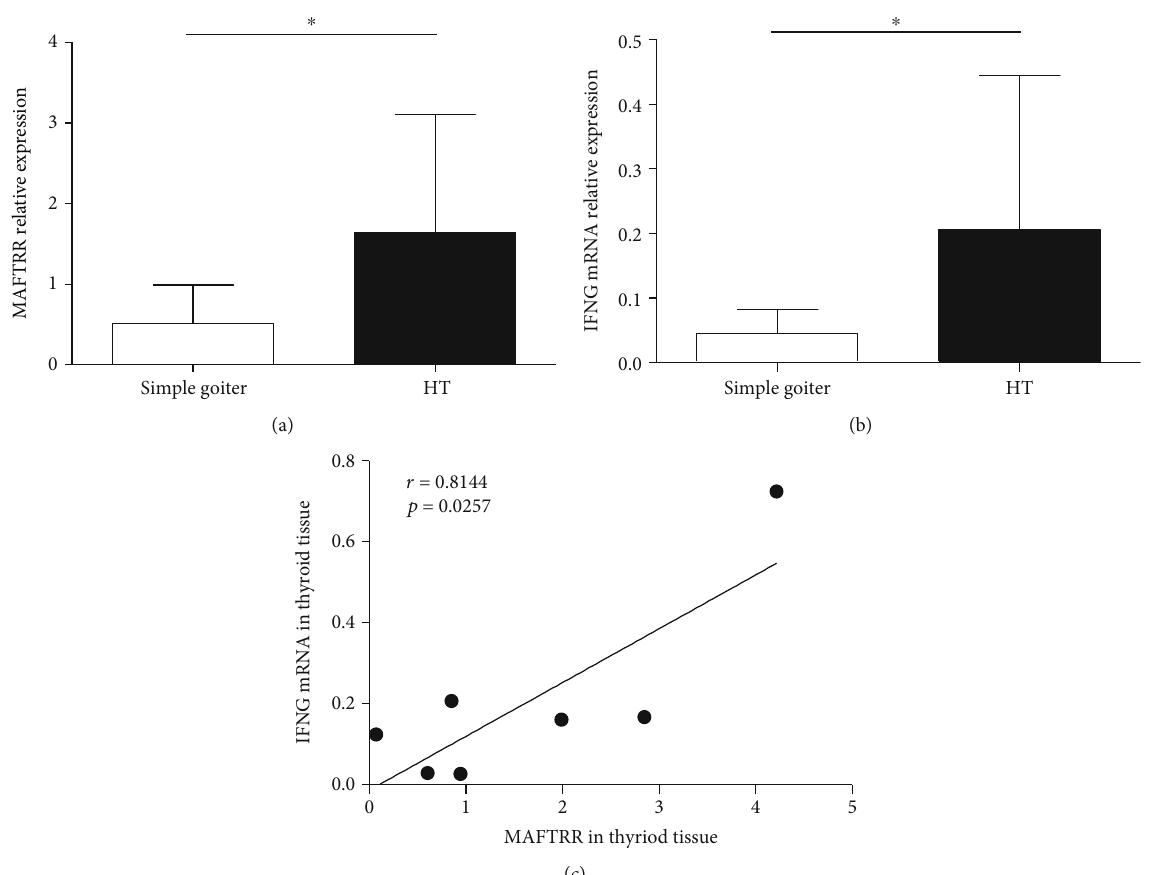
Figure 4: Elevated levels of MAFTRR and IFNG in thyroid tissues from the HT patients. (a) The transcript levels of MAFTRR in thyroid glands of patients with HT and patients with simple goiter were determined by qRT-PCR. (b) The transcript levels of IFNG in thyroid glands of patients with HT and patients with simple goiter were determined by qRT-PCR. (c) The correlation between the transcript levels of MAFTRR and the transcript levels of IFNG in thyroid glands of the HT patients is shown. Each data point represents an individual subject, and the horizontal lines show the mean. ∗ p < 0 : 05 .